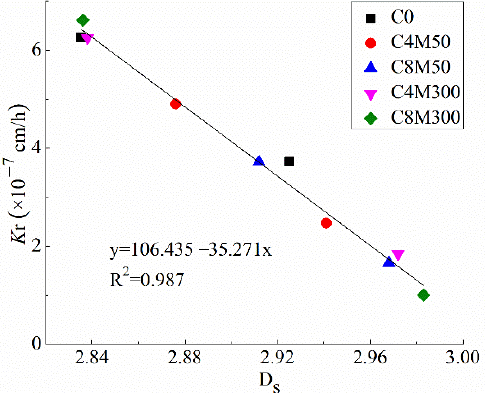
Figure 5. The correlation between the relative permeability coefficient (K r ) and D s .